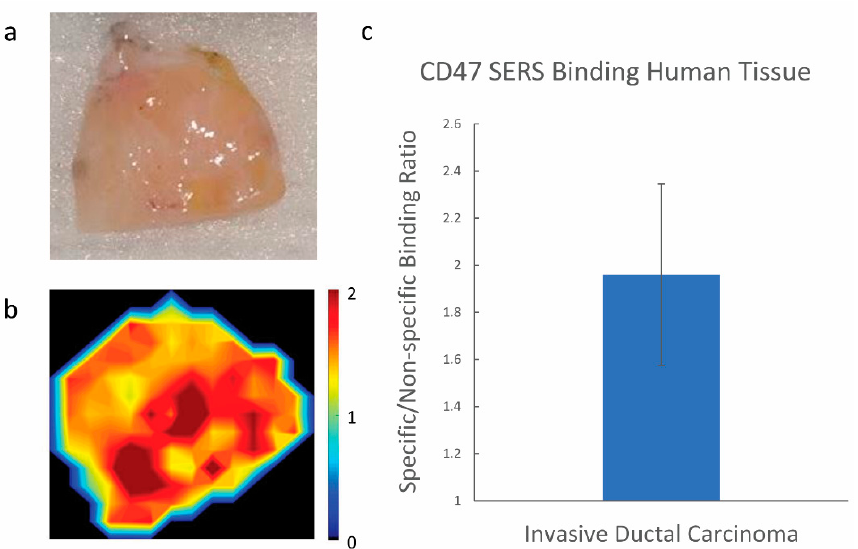
Figure 8. Raman imaging of resected invasive ductal carcinoma specimen from a 55-year-old patient. ( a ) Digital photo of excised tissue after NPs administration; ( b ) Raman imaging of tissue sample; ( c ) quantitative ratiometric analysis of specific CD47 SERS NP binding to non-specific Isotype IgG SERS NP binding on the human tissue sample. Scale bar represents the specific/non-specific binding ratio of our targeted/isotype-labeled nanoparticles.